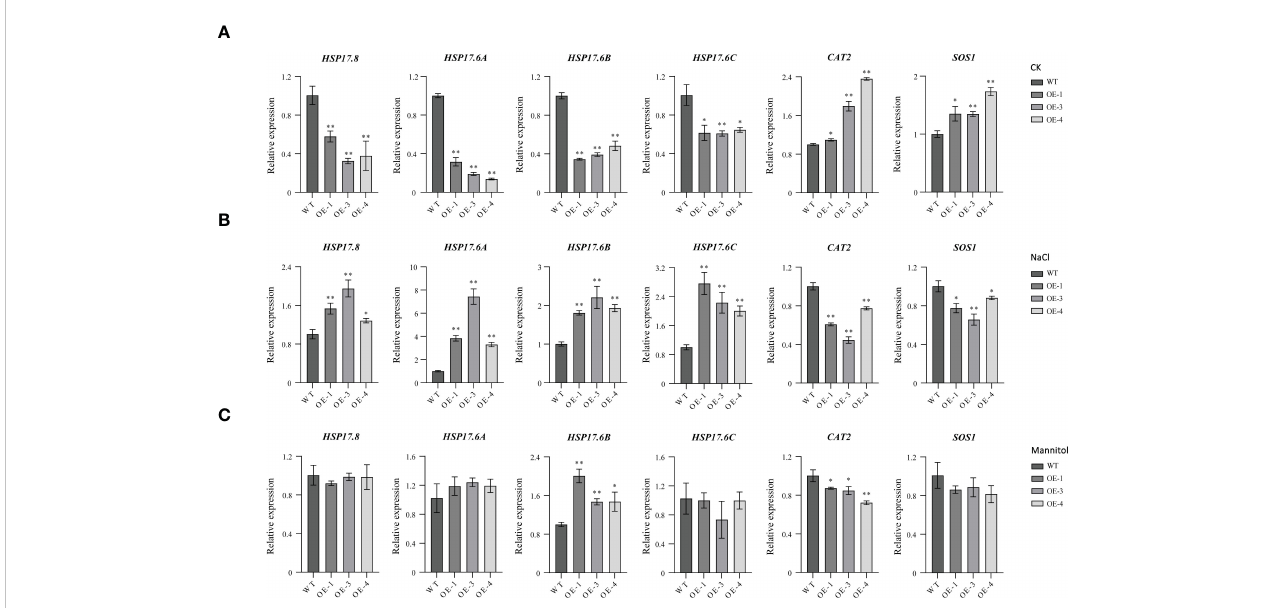
FIGURE 8 Expression analyses of abiotic stress related genes in WT and TaHSFB4-2B -OE lines under different abiotic stress. Seeds of WT and TaHSFB4-2B over expression lines of arabidopsis (OE-1, OE-3 and OE-4) were growing and treated and use method described in Figure 7. (A) Transcription levels of AtHSP17.8 , AtHSP17.6A , AtHSP17.6B , AtHSP17.6C , CAT2 and SOS1 growing under normal condition (CK), (B) NaCl treatment (100 mM NaCl), (C) mannitol treatment (200 mM mannitol) were quanti fi ed by RT-qPCR. The transcription level of TaHSFB4-2B was normalized with AtACTIN2 . Values are Mean ± SD, n=3. * P < 0.05 and ** P < 0.01 (Student ’ s